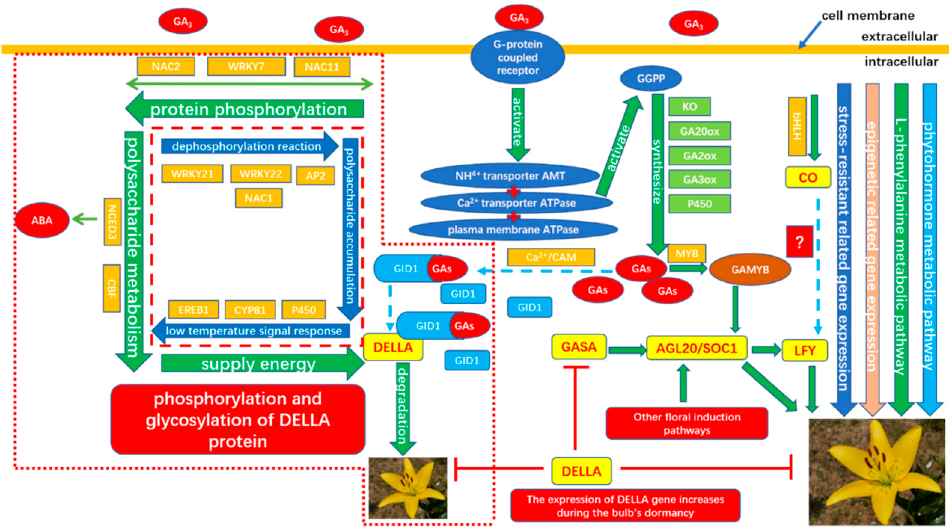
Figure 28. The molecular mechanism of floral transition induced by exogenous GA 3 in LA hybrid lily ‘Aladdin’.